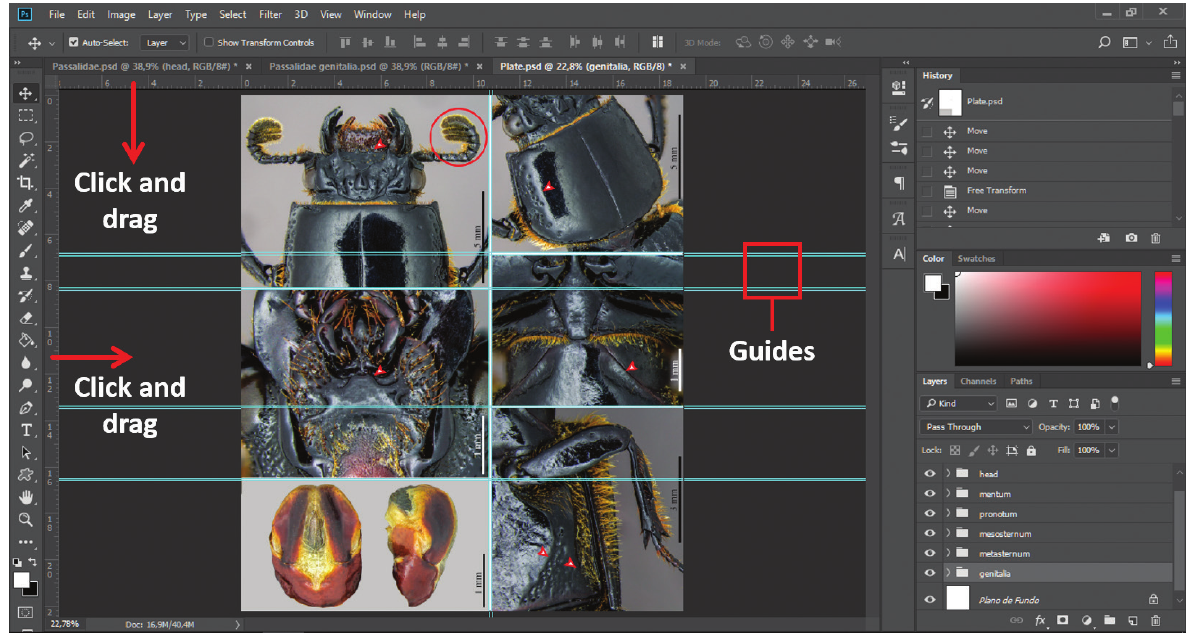
Figure 29. Photos positioned on the figure document using guidelines to adjust the position of